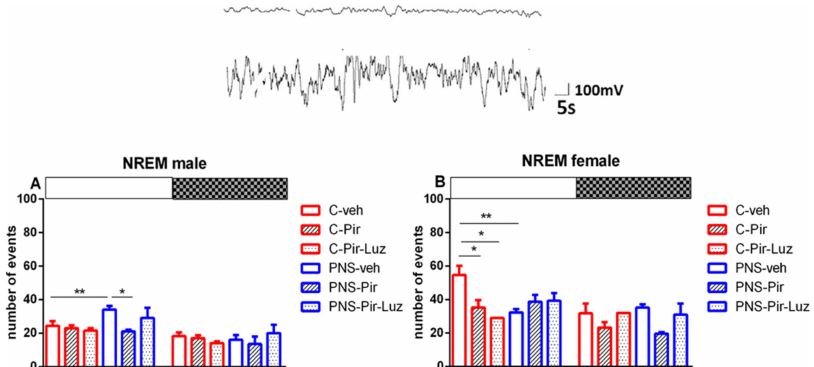
Figure 6. Representative EEG (frontal cortex) and EMG (neck muscle) recording during NREM sleep of the control group. Diurnal rhythm of the number of NREM events in male ( A ) and female rats ( B ) during the Light and the Dark phase, indicated by open and black rectangles above the figure, over a 24-h recording for the C-veh, C-Pir, C-Pir-Luz, PNS-veh, PNS-Pir and PNS-Pir-Luz group. * p < 0.05, ** p < 0.01.